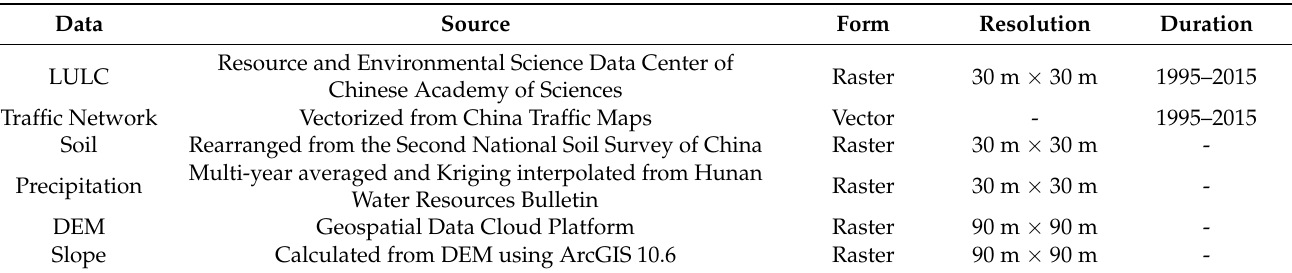
Table 3. Basic information of input